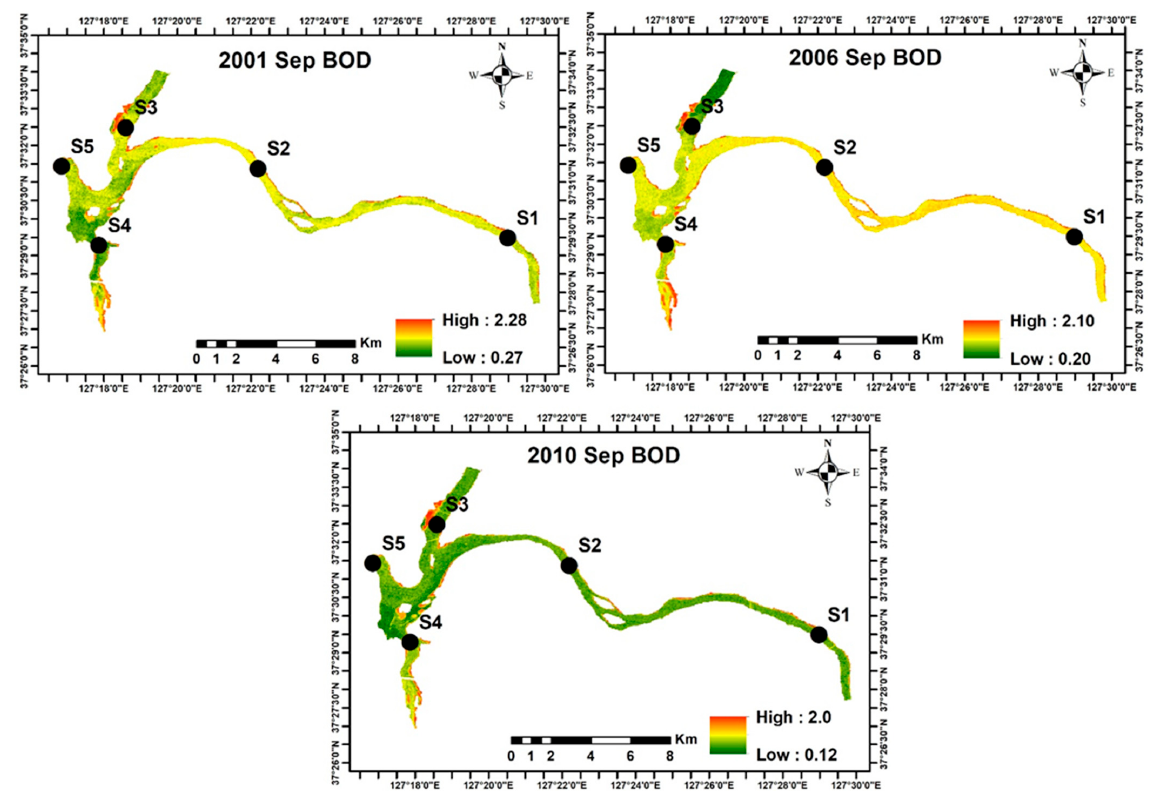
Figure 5. Spatial and temporal pattern of biological oxygen demand (BOD) on September 2001, 2006 and 2010.